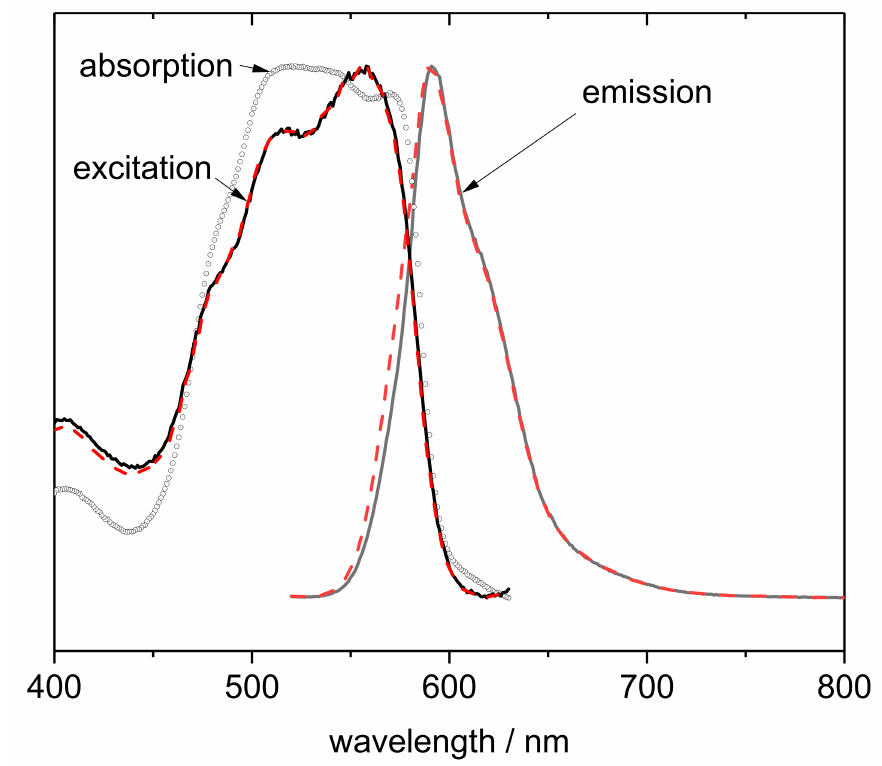
Figure 6. Spectra of polyurethane composite membrane modified with organoclay particles function- alized with PhB. The spectra were normalized to the maximum